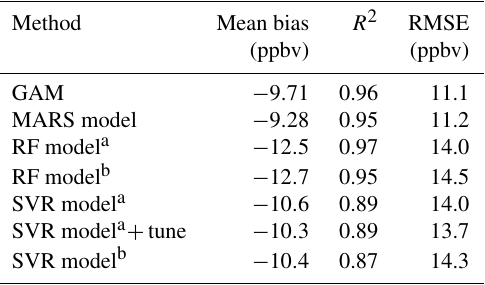
Table 2. Summary of statistical results of the fourth MDA8 ozone predictions using four methods at the Crestline